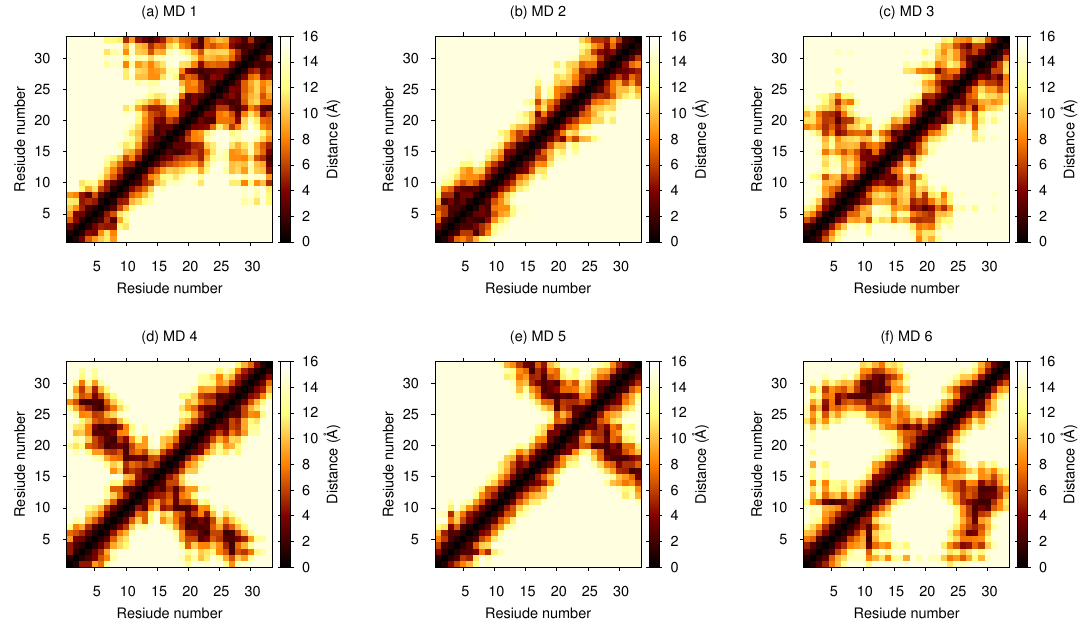
Figure 5. Distance maps depicting distance between amino acid residues for each representative structure of top six clusters from MD simulation.